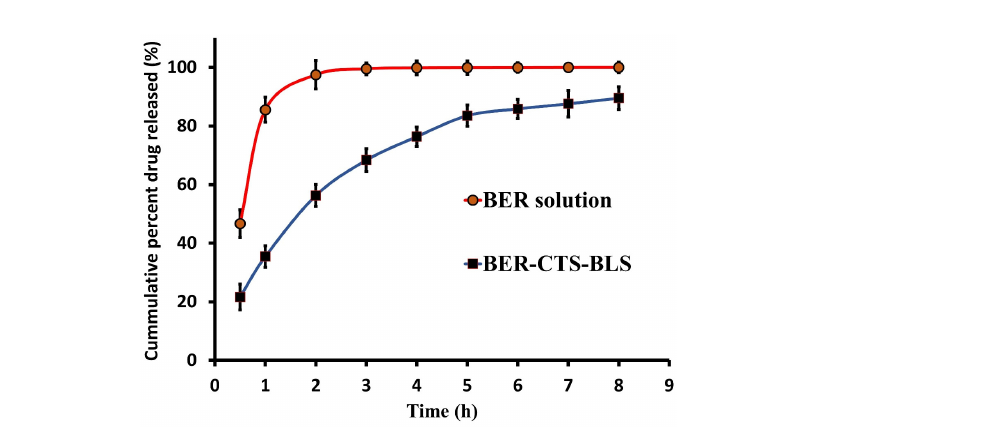
Figure 4. In vitro release profile of berberine from BER-CTS-BLS (optimal formula) and BER solution.